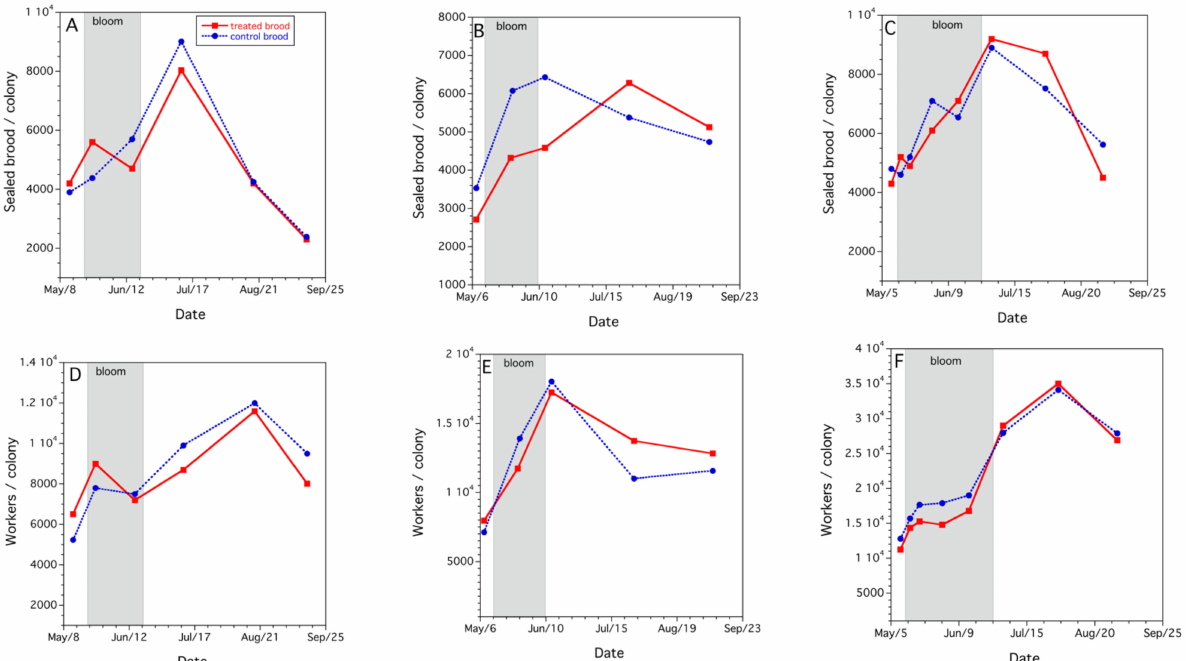
Figure 7. Sealed brood populations estimated over time from before bloom to early fall, 2011 ( A ), 2012 ( B ), 2013 ( C ). Worker bee populations estimated over time from before bloom to early fall, 2011 ( D ), 2012 ( E ), 2013 ( F